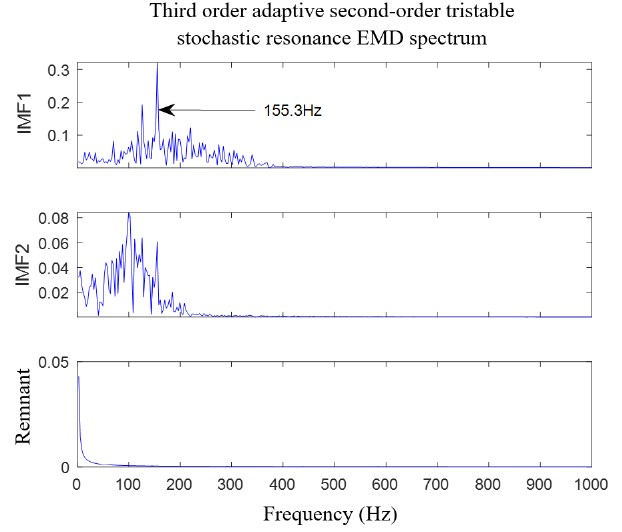
Figure 22. The processing results of the third cascaded stochastic resonance.